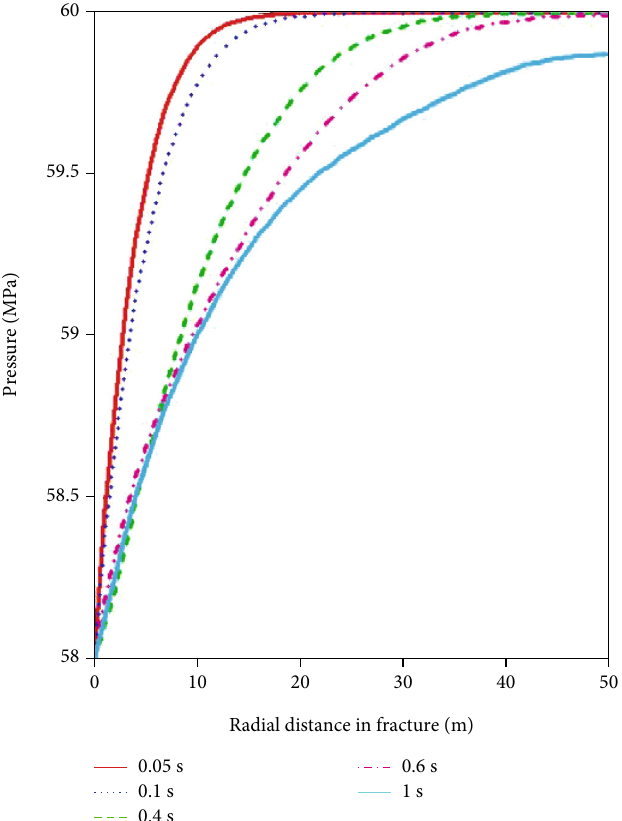
Figure 4: Radial pressure drop funnel in fracture.